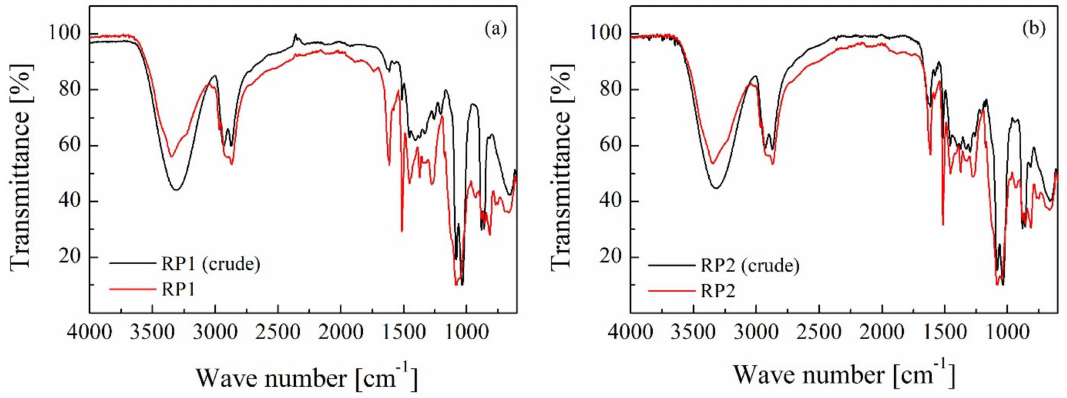
Figure 1. FTIR spectra of ( a ) crude and distilled RP1 and ( b ) crude and distilled RP2. All polyols show absorption peaks corresponding to the stretching vibrations of the hydroxyl groups (O-H) around 3345–3420 cm − 1 , and sp 3 stretching vibration of the C- H bond (2870 and 2968 cm − 1 ). Absorption peaks at 1373 and 1454 cm − 1 correspond to bending vibrations of the methyl (-CH 3 ) bond in the polyol chain, while the most prominent characteristic peak is the one at 1082 cm − 1 corresponding to stretching vibrations of the C-O-C group. However, FTIR spectra of RPs present some differences compared to the CP as seen in Figure 2. Characteristic peaks at 1737 cm − 1 corresponding to the C=O bond of the urethane and urea groups and bending vibrations of the N-H bond (1514 and 1614 cm − 1 ) are observed due to the limitation of the PU glycolysis reaction. The high intensity of the characteristic peak of the latter bond could also indicate the presence of amines in the